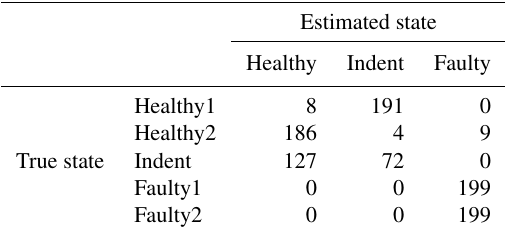
Table 5. Accuracy values for classifier training with ramp-up data.